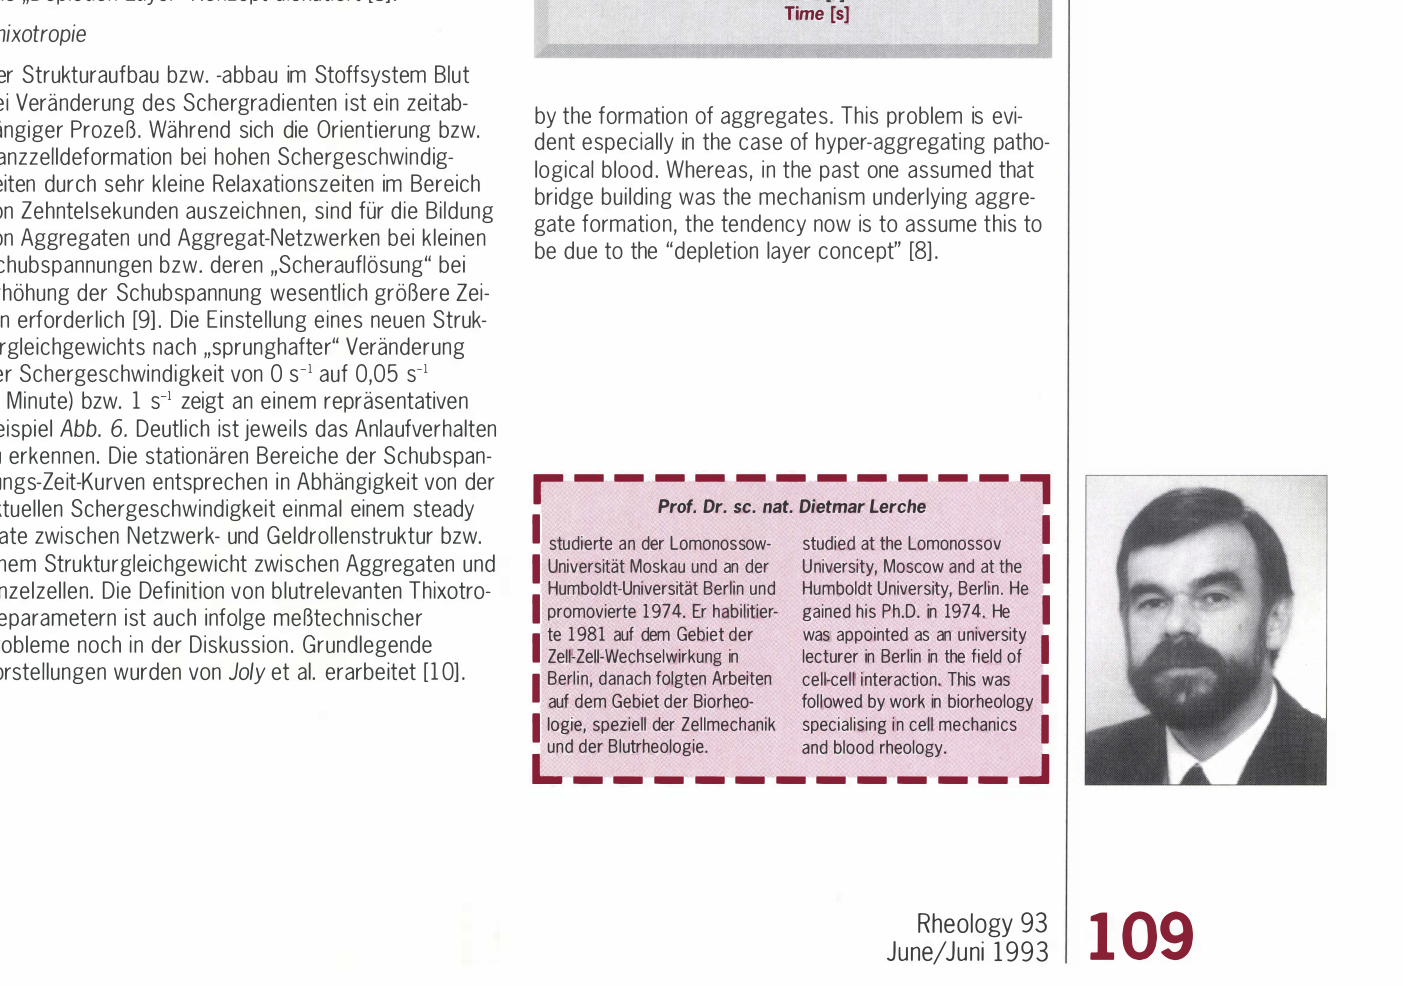
Fig. 6: Shear stress values as a function of time for ramp shear